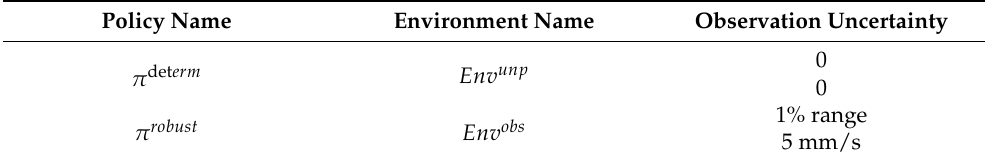
Table 4. Different control strategies and different environments.